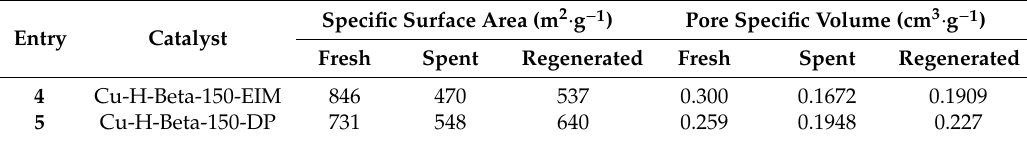
Table 3. Specific surface area, pore volume of the fresh, spent, and regenerated Cu-H-Beta-150-EIM, Cu-H-Beta-150-DP catalysts.